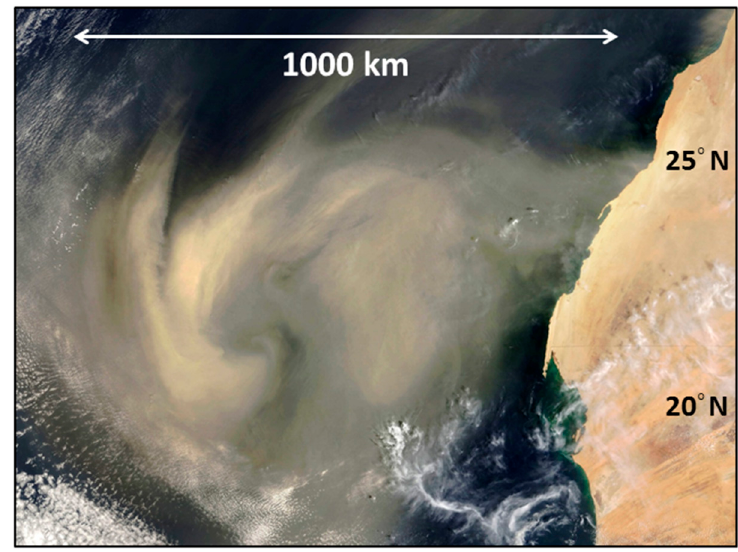
Figure 1. Synoptic-scale plume of Saharan dust o ff the West Coast of Africa on 4 September 2005. Moderate-Resolution Imaging Spectroradiometer (MODIS) satellite (visible) image, courtesy NASA.